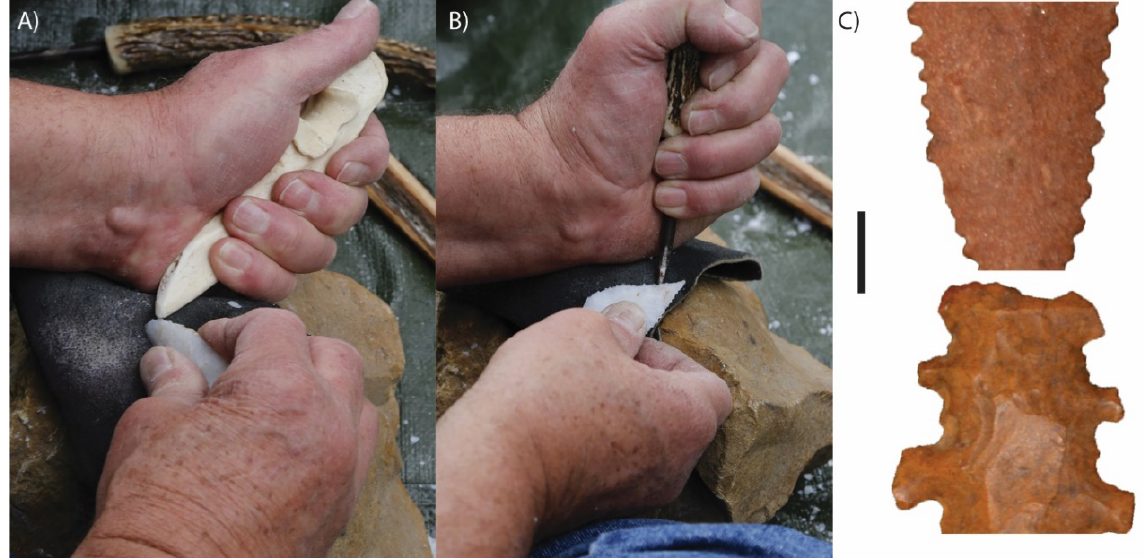
Figure 5. Orientation of pressure flaking tools. A) Large bone pressure flaker used to remove invasive collateral pressure flakes. B) Fine chisel ended metal pressure flaker, used to create serrate marginal projections. C) Semi- circular flake scars adjacent to marginal projections. Scale bar is